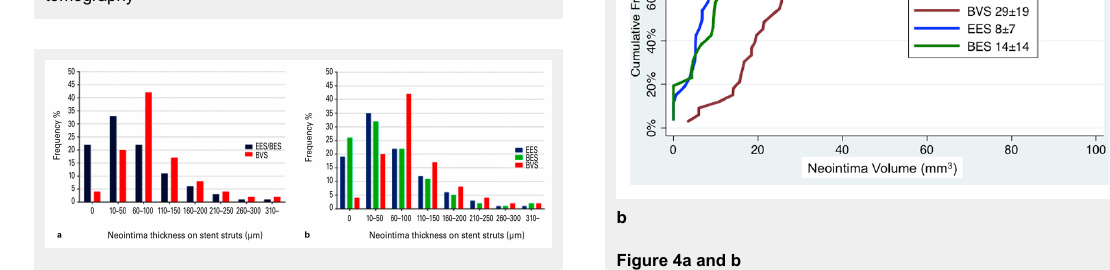
Patient flow chart. BES = biolimus-eluting stent; BVS = bioresorbable vascular scaffold; EES = everolimus-eluting stent; OCT = optical coherence tomography